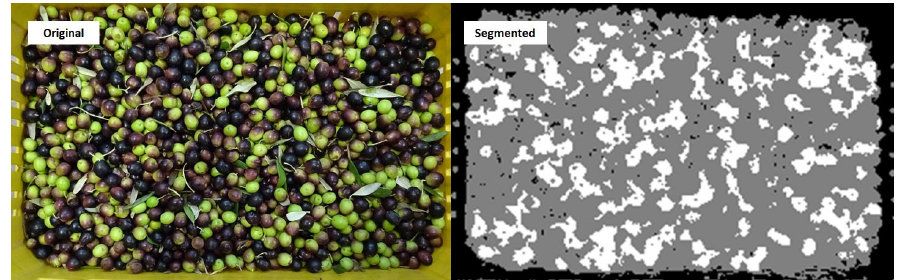
Figure 2. Comparison between the original image ( left ) and the segmented image ( right ) according to the 7-class k-nearest neighbors (k-NN) classification algorithm.